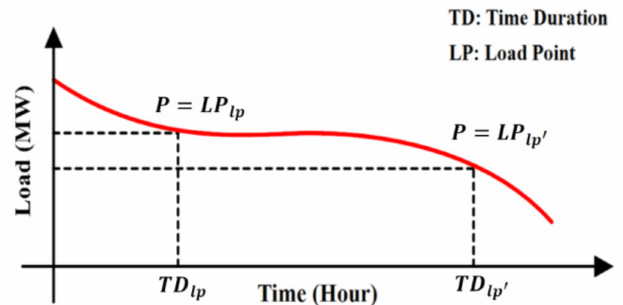
Figure 1. The diagram of load